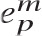
Performance of different softening formalisms (different colors) with softening parameter ς = 10−3 in the potential of a Quartic disc, see Eq. (23), with the eccentricity profile (24). The disc extends from ain = 0.1 AU to aout = 5 AU. Shown as a function of semi-major axis ap are the profiles of (A) the amplitude epm of the disc-induced eccentricity oscillations, (B) the rate of disc-driven free precession Ad, and (C) the coefficient Bd appearing in the non-axisymmetric part of the disturbing function (4). The black lines represent the expected unsoftened results as computed by Davydenkova & Rafikov (2018). Curves for Hahn (2003) and Touma (2002) fall on top of the unsoftened results, while the softening method of Tremaine (1998) shows only qualitative agreement.